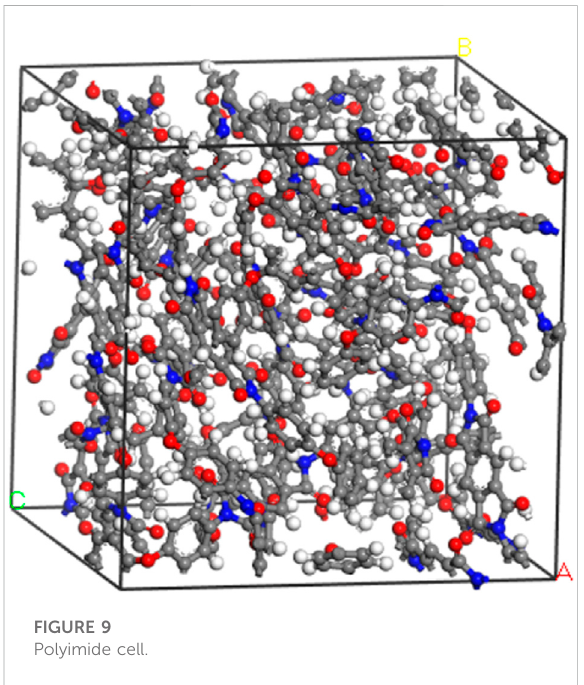
FIGURE 9 Polyimide cell.